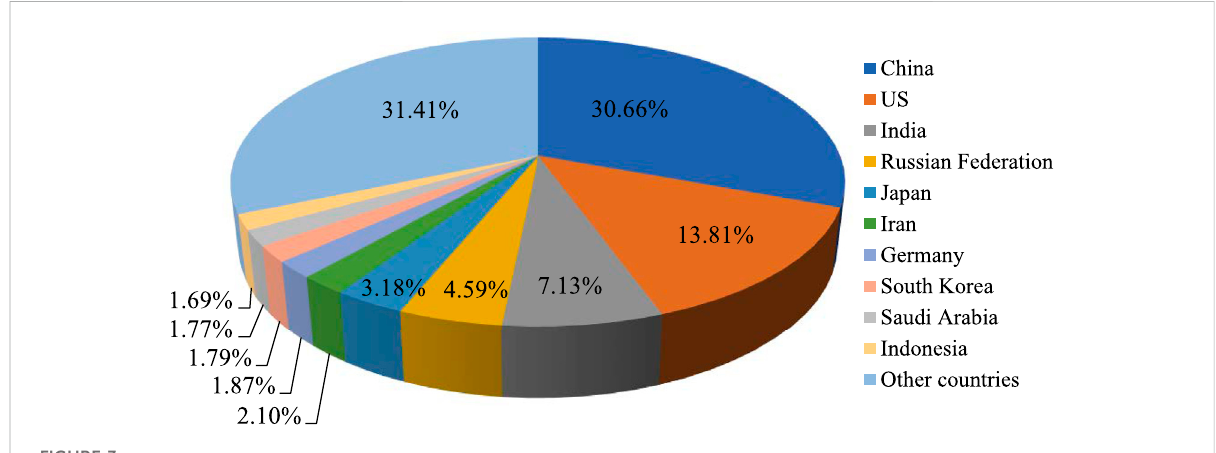
FIGURE 3 Proportion of carbon emissions of the major countries in the world (Date from BP Statistical Review of World Energy 2021. 70th